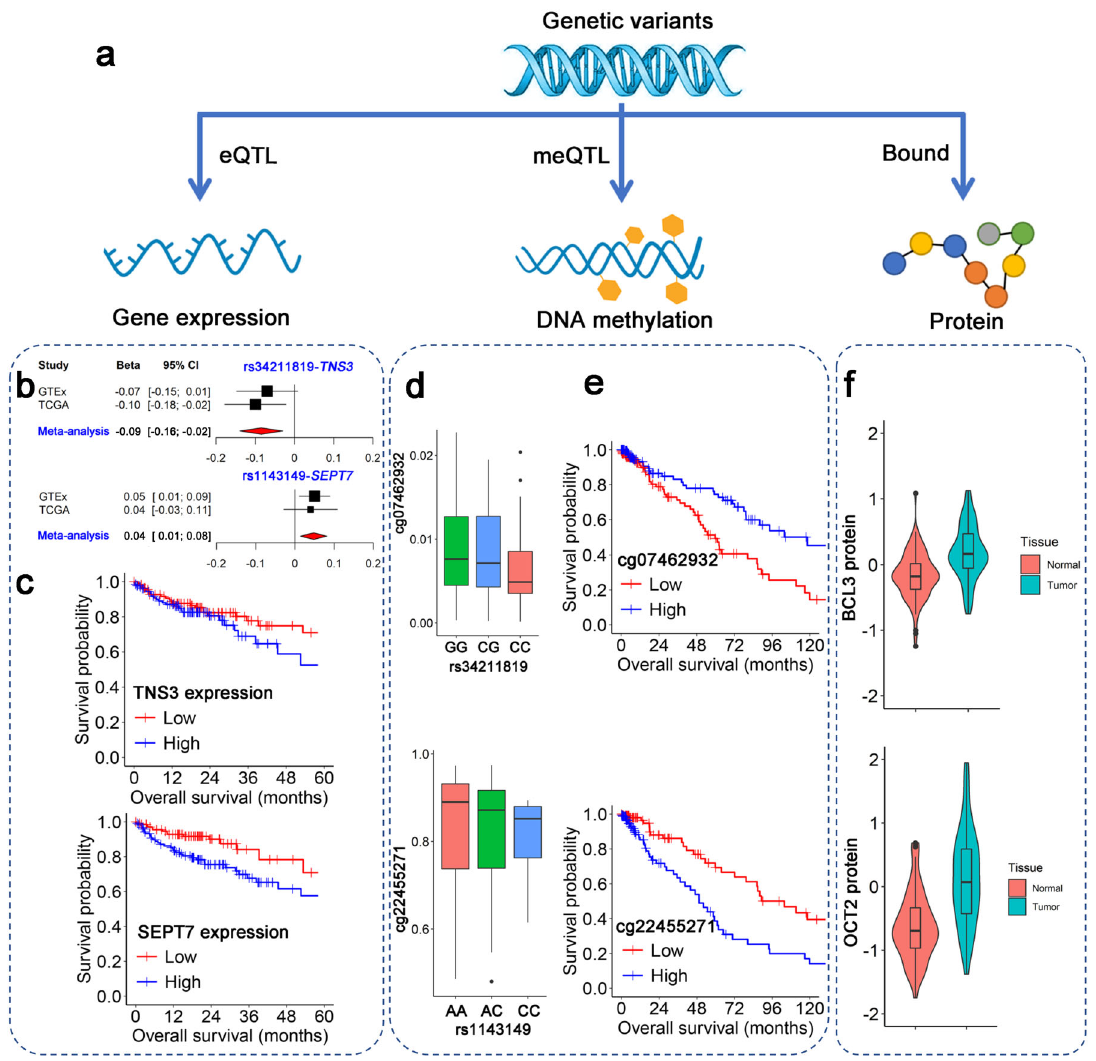
Fig. 3 Multi-omics analyses for TNS3 and SEPT7 . a Multi-omics analyses fl owchart. We observed signi fi cant eQTL/meQTL relationship, survival-related methylation, and expression patterns and upregulated proteins in NSCLC. b Signi fi cant eQTLs were observed for the two SNPs and cis genes. c Kaplan – Meier survival curves for expression of both genes using TCGA long-term former smoking patients. d meQTL boxplots of the two CpG probes and SNPs. e DNA methylation survival analysis for the two CpG probes. f Proteins BCL3 and OCT2 bound by SNPs also differed between tumor and normal